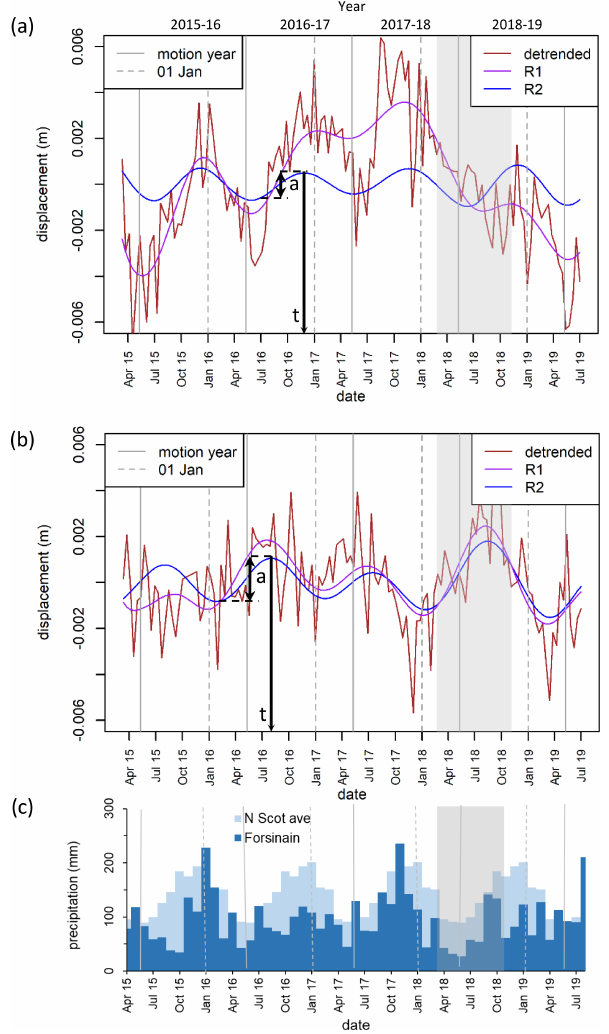
Figure 2. Examples of surface motion time series and the met- ric definitions for (a) “soft” wet bog and (b) a “stiff” drier bog, calculated from Sentinel-1 APSIS InSAR time series data between 12 March 2015 and 1 July 2019 against (c) monthly precipitation for northern Scotland (UK Met Office 20-year average, light blue) and Forsinain in the Flow Country (Scottish Environment Protection Agency, Dark blue). The initial mean detrended time series (brown), and multichannel singular spectrum analysis (MSSA) reconstruc- tions (R1) retaining the local climate trend (purple, a combination of empirical orthogonal functions 1–6) and R2 annual seasonal cy- cles (blue, a combination of empirical orthogonal functions 5 and 6) are shown. The two surface motion metrics used in the analysis are peak timing ( t ) and amplitude ( a ) shown for the surface motion year 10 May 2016 to 9 May 2017. A third surface motion metric, multi- annual average velocity, is not illustrated here as it is part of the In- SAR data processing (Sect. 3.1). This asynchronous timing of peaks between (a) and (b) forms a bimodal distribution in the peak ampli- tude timing of the peatland landscape. The drought event of 2018 (Buras et al., 2020) is shaded and can be seen to influence relative surface motion with a local climate trend in the soft, wet bog (a)